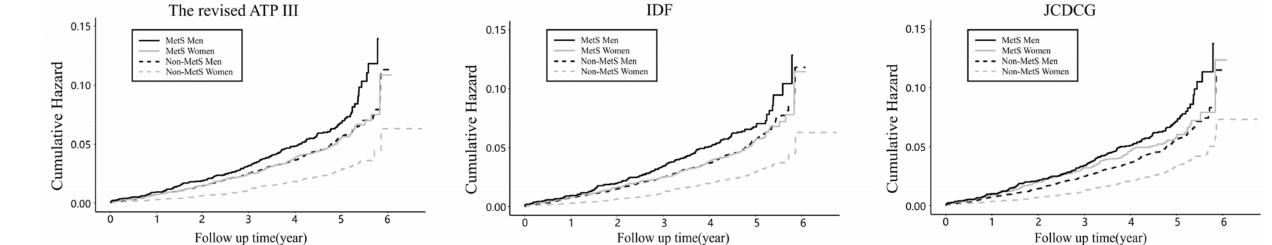
Figure 1. Cumulative hazard of CVD events stratified by sex and MetS. IDF International Diabetes Federation; the revised ATP III, the revised US National Cholesterol Education Program Adult Treat- ment Panel III; JCDCG, the Joint Committee for Developing Chinese Guidelines; CVD, cardiovascular disease; and CHD, coronary heart disease.